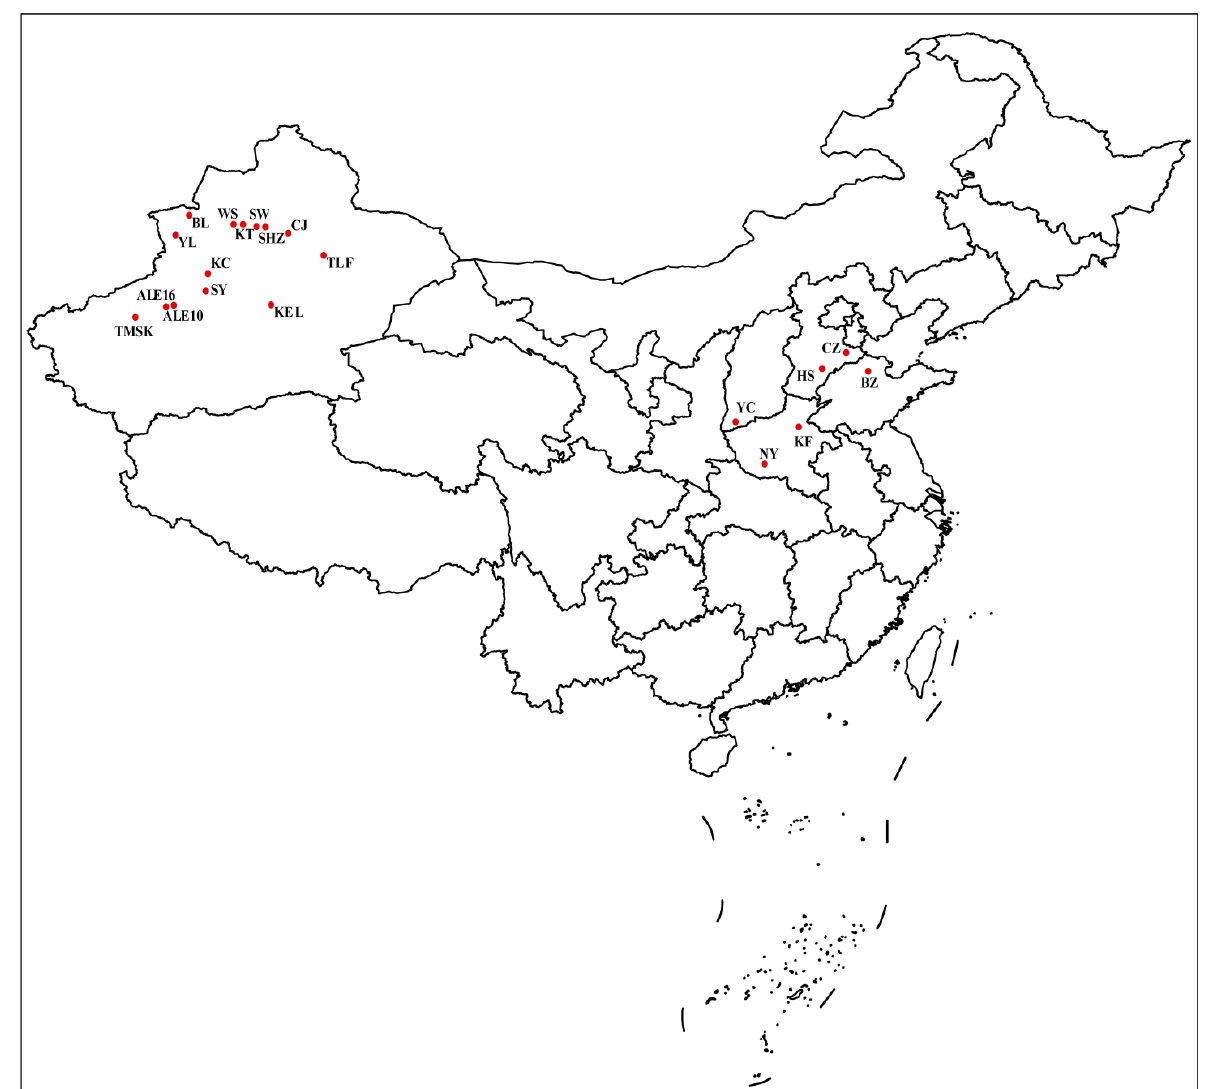
Figure 1. Geographical distribution of Aphis gossypii samples in